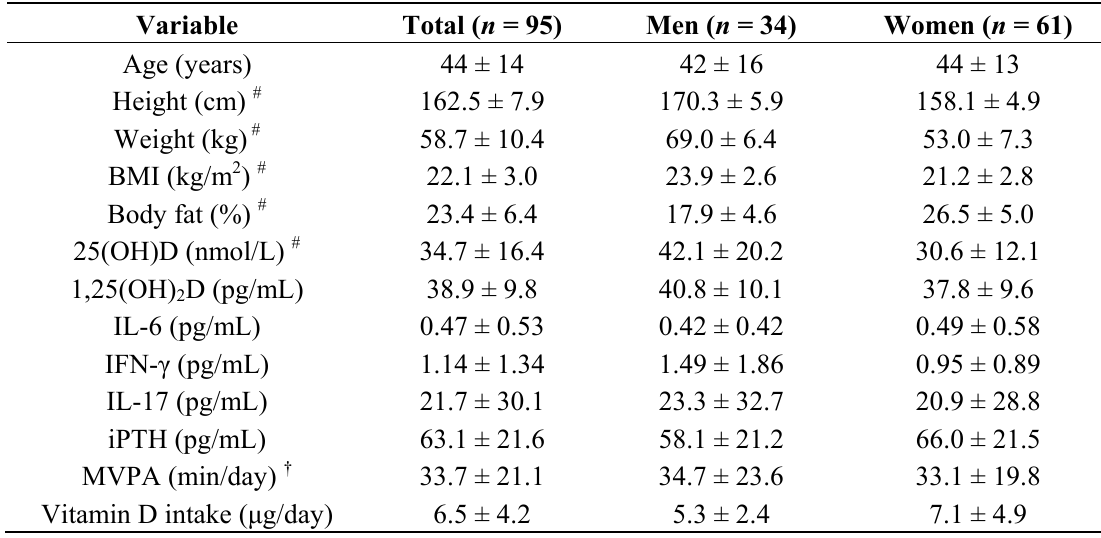
Table 1. Subject characteristics according to